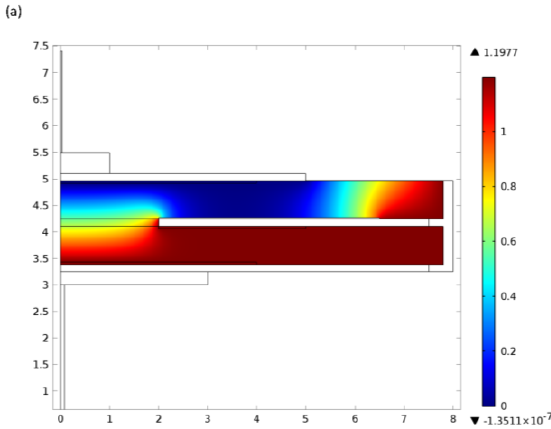
Figure 6. Example of electrochemical oxygen pump model outputs. ( a ) Dissolved oxygen distribution; ( b ) Dissolved oxygen flux; ( c ) Gas phase oxygen